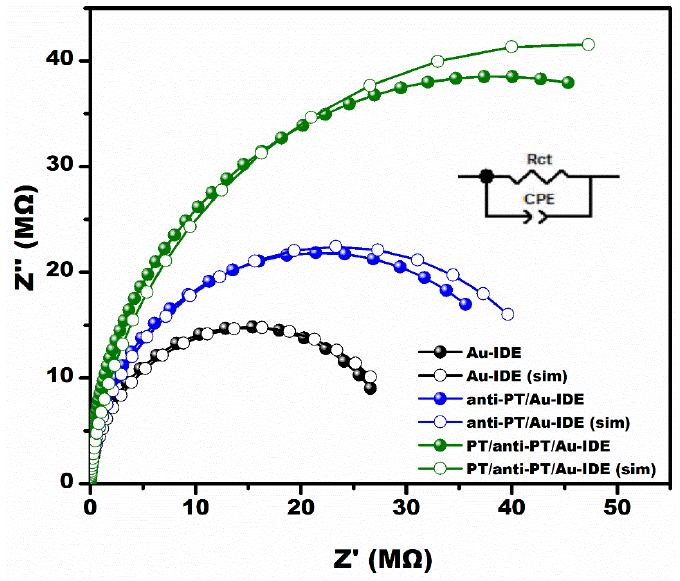
Figure 5. Impedance spectra at different surface modification stages of Au-IDE along with the Ran- del’s equivalent circuit used to model electrode–electrolyte interfaces and curve fitting of impedance spectra by circuit simulation at different modifications of Au-IDE surfaces.